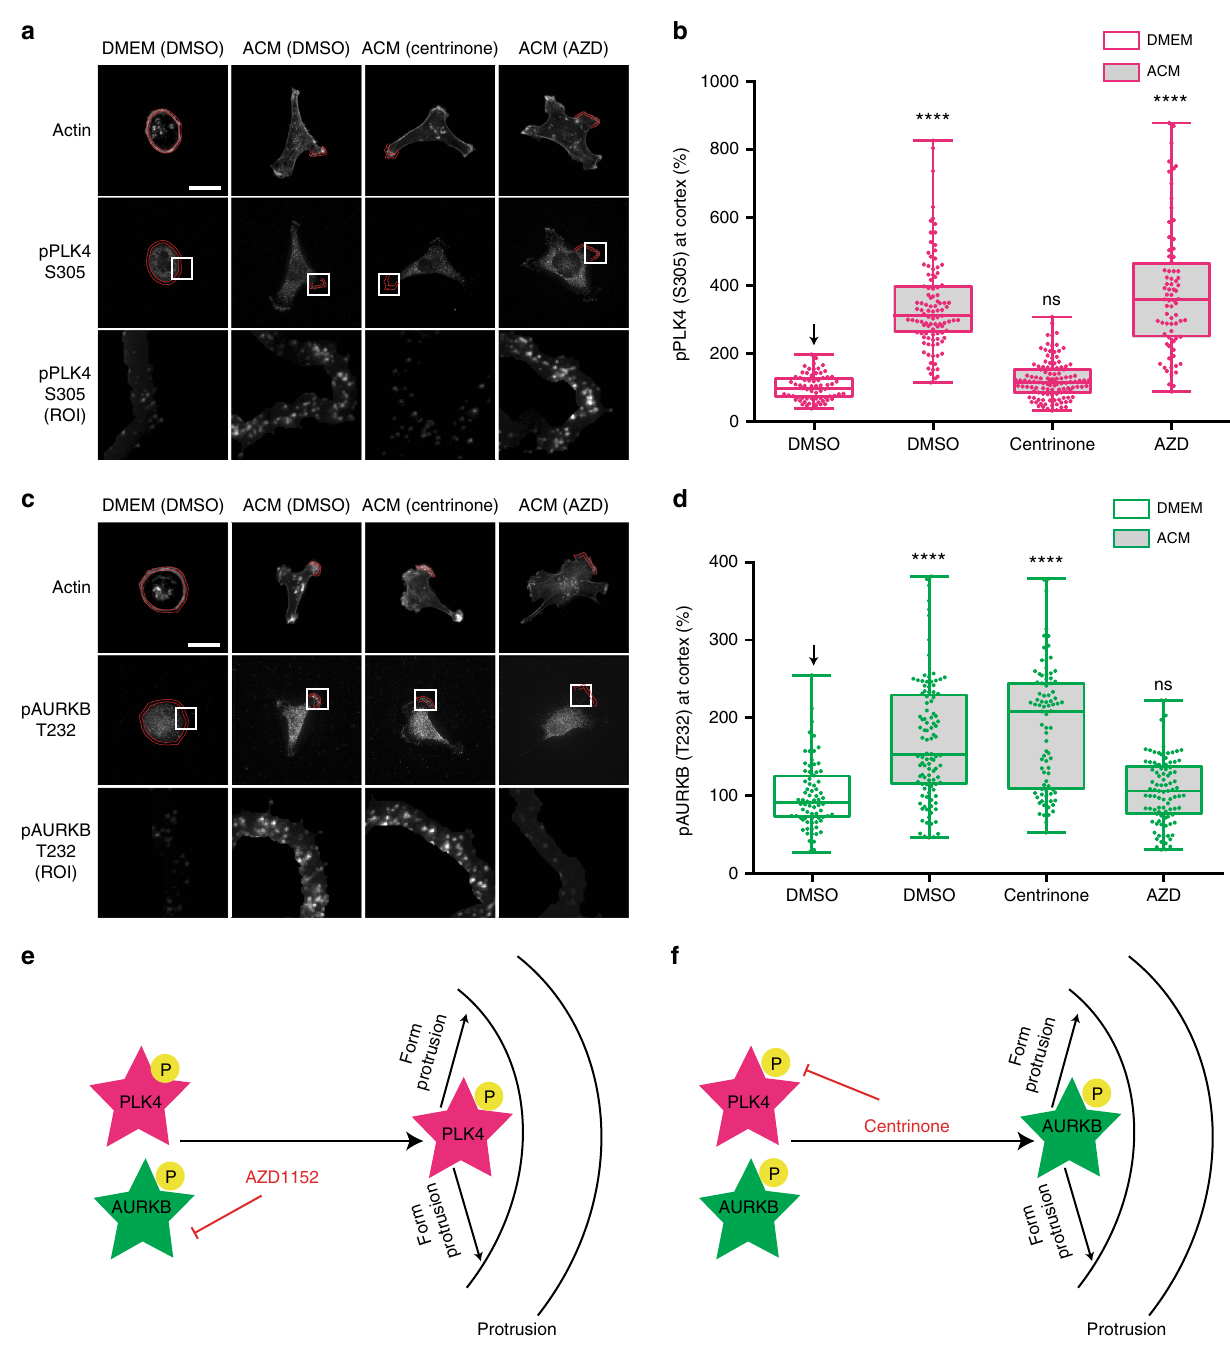
Fig. 6 PLK4 and AURKB accumulation at cell protrusions depends on their speci fi c activity. a , c MDA-MB-231 cells were stimulated with DMEM or ACM in the presence of DMSO, centrinone or AZD. Cells were stained for actin and ( a ) phospho-PLK4 (S305), or ( c ) phospho-AURKB (T232). Bar = 20 µ m. b, d Intensity at cortical region for ( b ) phospho-PLK4 (S305), or ( d ) phospho-AURKB (T232) from cells in ( a ) and ( c ) was measured. The data was analysed as described in Methods and plotted as box and-whiskers. Boxes represent median and 25th to 75th percentiles, whiskers the minimum and maximum values with each individual value superimposed. The data were compared with one-way ANOVA Kruskal – Wallis test and post-tested with Dunn ’ s multiple comparison test. Arrow indicates the control bar used for comparison (**** p < 0.0001; n = 3, at least 60 cells were measured per condition). Magenta is phospho-PLK4, dark green is phospho-AURKB. Models for phospho-PLK4 (S305) ( e ) and phospho-AURKB (T232) ( f ) localisation at the cell cortex to promote protrusion formation that occurs independently from the other kinase